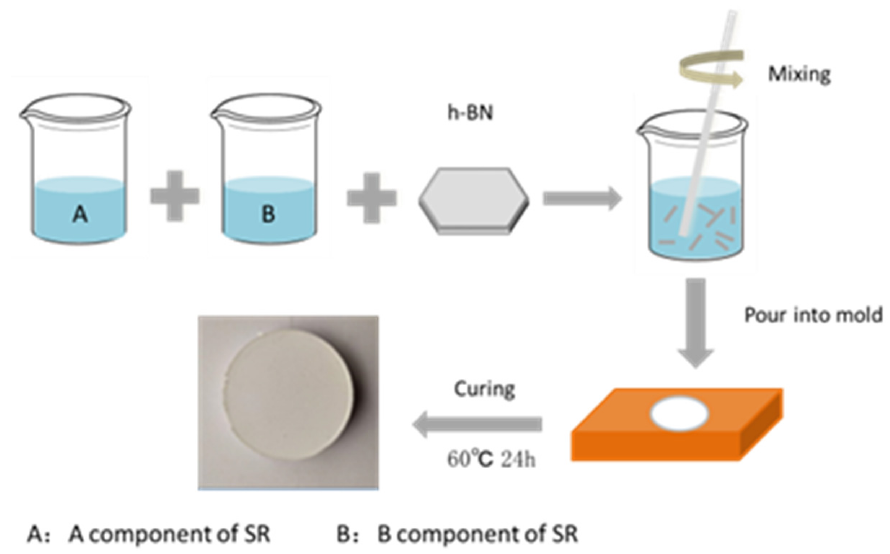
Figure 1. Illustration of preparation of hexagonal boron nitride and silicone rubber (h-BN/SR) composite.